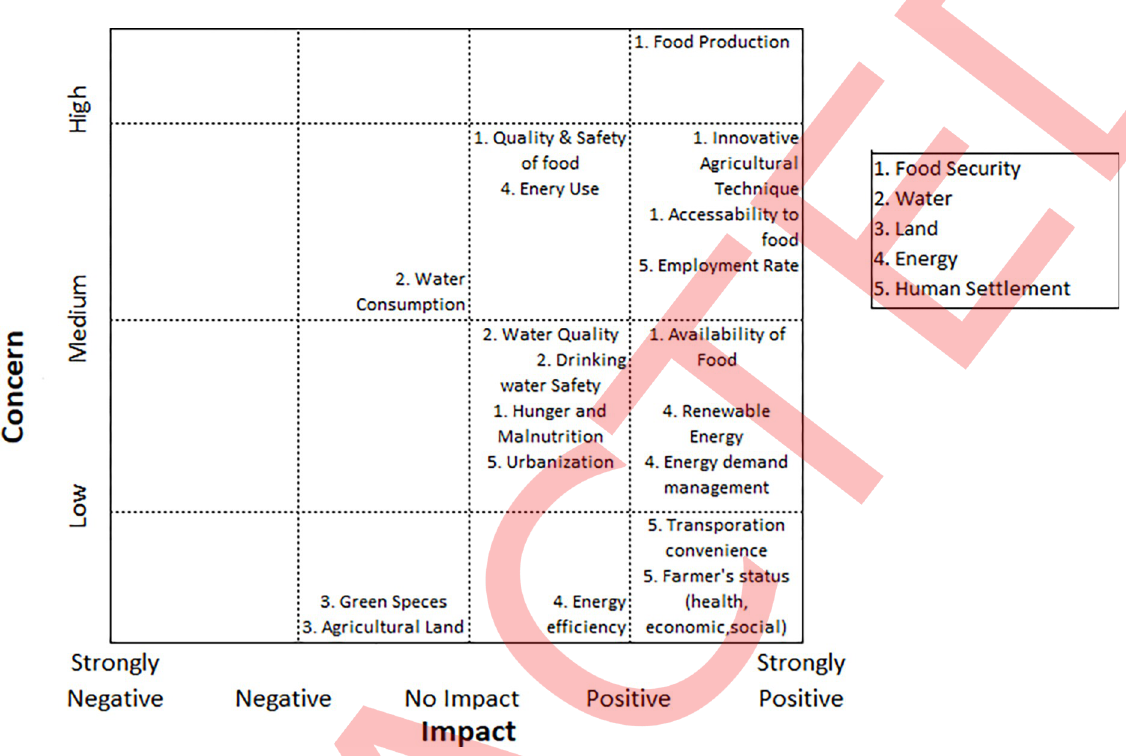
Fig 6. Prioritization matrix of social and food security impacts in the process of CPEC in